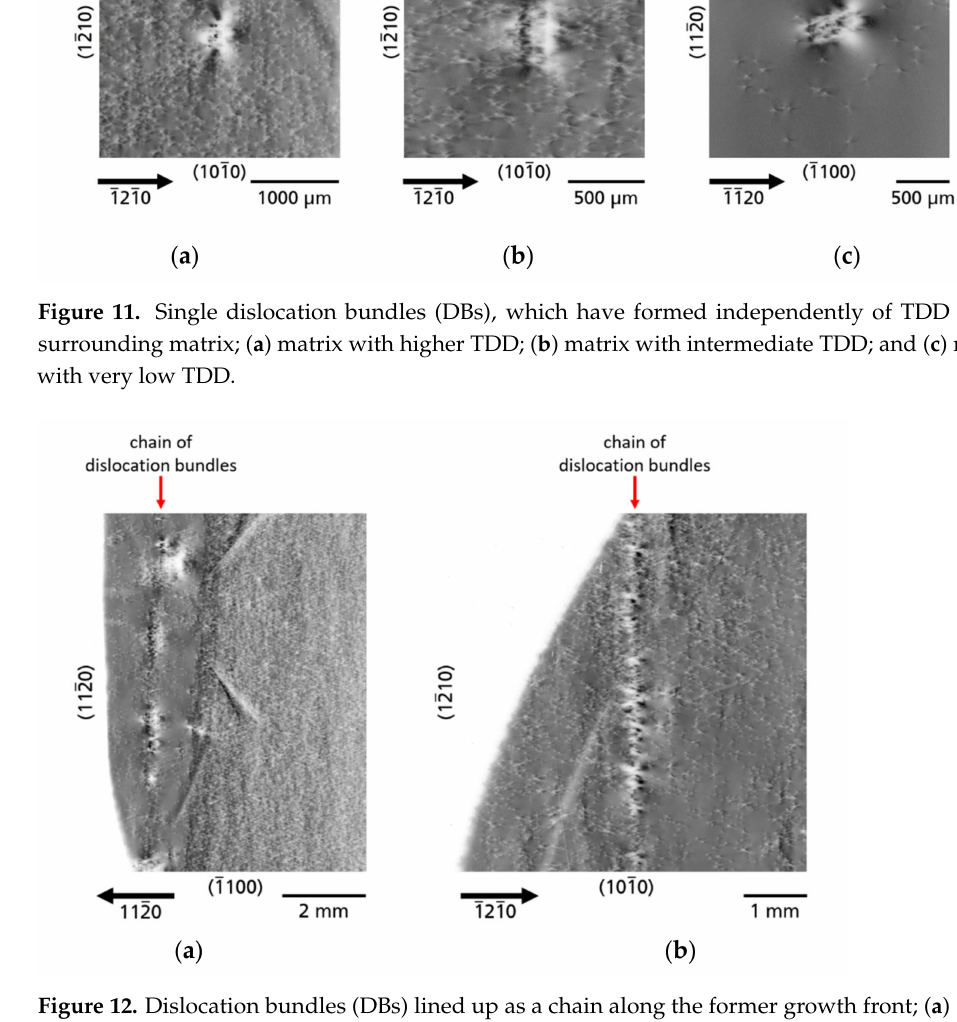
Figure 12. Dislocation bundles (DBs) lined up as a chain along the former growth front; ( a ) “inter- rupted chain of DBs”; ( b ) “continuous chain of